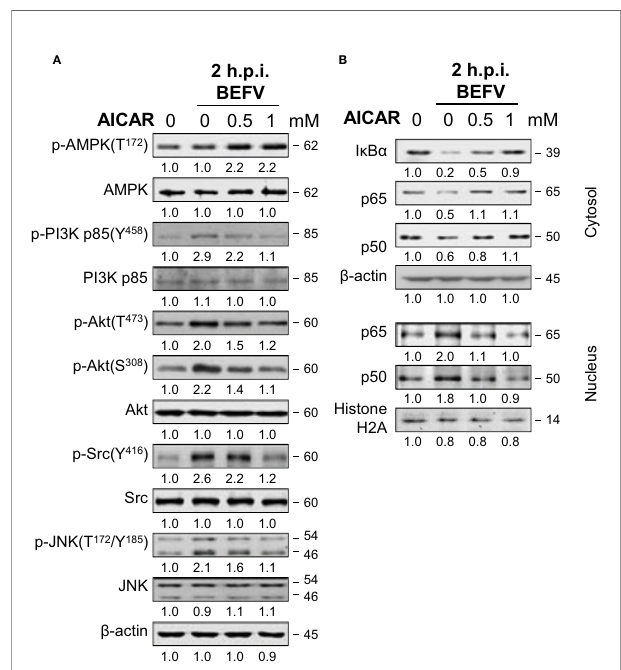
FIGURE 4 | BEFV activates the PI3K/Akt/NF- k B and Src/JNK/AP-1 pathways in the early stage and is suppressed by 5-aminoimidazole-4- carboxamide-1- b -riboside (AICAR). MDBK cells were pretreated with or without AICAR (0.5 and 1 mM), respectively, for 30 min, followed by infection with BEFV at an MOI of 1 for 2 h. (A) The cell lysate or (B) cytosolic and nuclear fraction were collected and subjected to immunoblotting with the respective antibodies as indicated. The levels of indicated proteins in the mock group were considered onefold. The activation and inactivation folds indicated below each lane were normalized against values for the mock control group. b ‐ actin was used for the internal control for normalization.Signals in all Western blots were quanti fi ed with ImageJ software. All experiments were conducted in three independent experiments. The predicted size of each protein was labeled at the right-hand side in